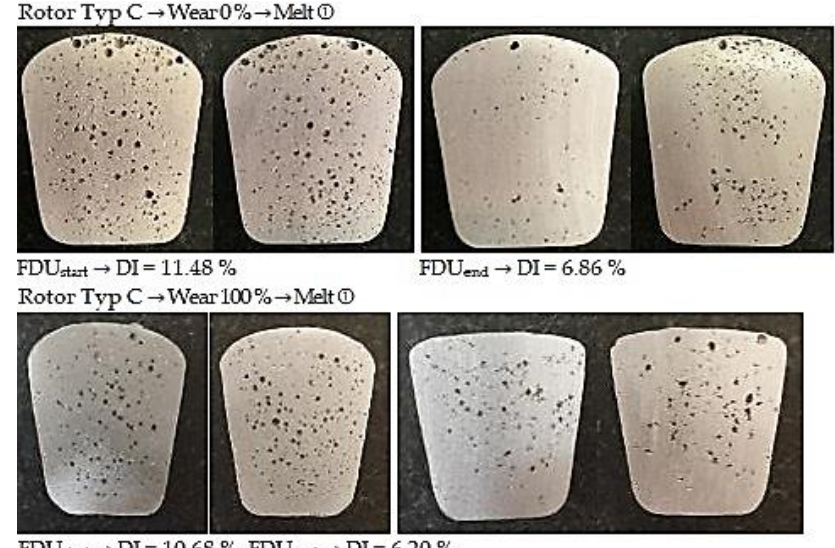
Figure 8. Comparison of degassing at 0% and 100% wear for Type C rotor.